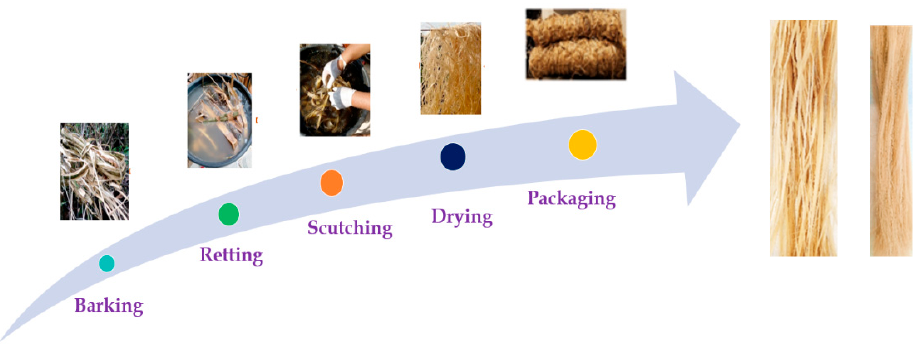
Figure 1. CL fiber extraction process: from bark to ribbons of fibers.